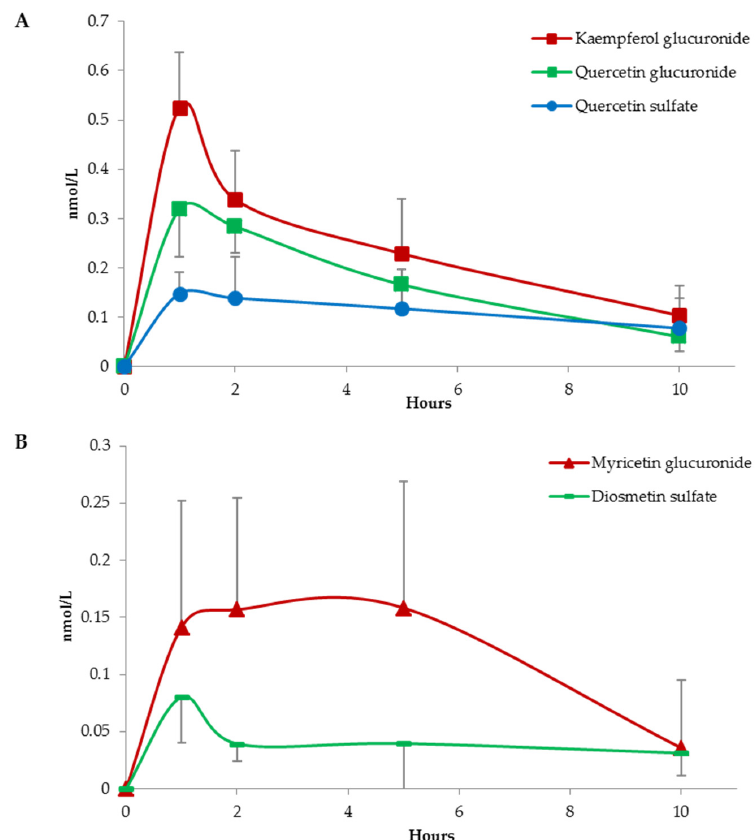
Figure 1. Absorption curves of kaempferol glucuronide, quercetin glucuronide, quercetin sulfate in graph ( A ); and myricetin glucuronide and diosmetin sulfate in graph ( B ). Data are expressed as mean values and bars represent standard error of means (SEM).